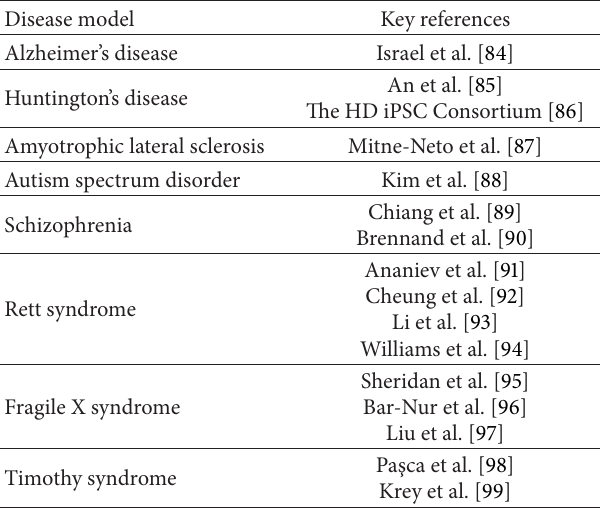
Table 3: In vitro modeling of neurodegenerative and neurodevelop- mental disorders with hPSCs-derived neuronal